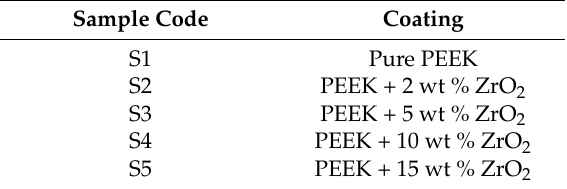
Table 1. The poly-ether-ether-ketone (PEEK) based composite coatings on Ti6Al4V